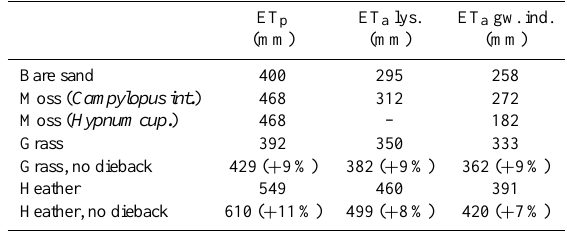
Table 7. Modeled ET p and ET a for different surfaces in a lysimeter (lys.) and for a situation with deep groundwater levels (gw. ind.) for the year 2013.